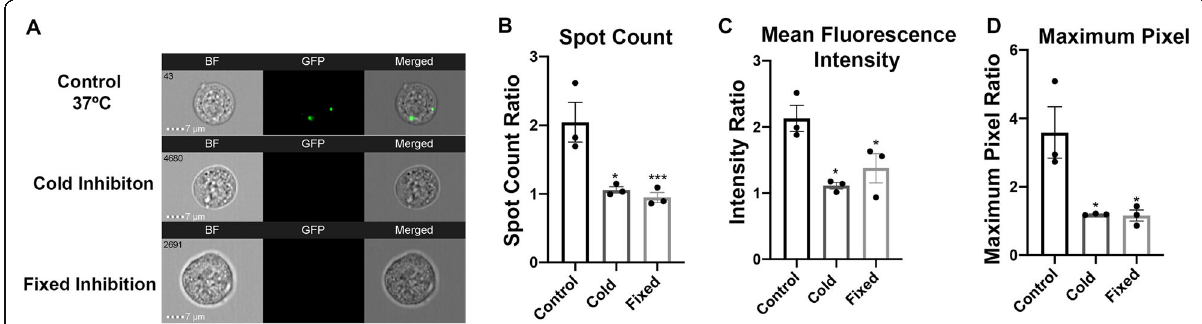
Fig. 2 EV internalization inhibition assays. HEK293T cells were co-cultured with HEK293T EVs under various conditions. Control (37 °C) refers to co- culture in physiological 37 °C environment. Cold refers to co-culture in a 4 °C environment. Fixed inhibition refers to an assay where recipient cells were PFA fixed prior to co-culture. a Representative IFC images of recipient cells. Column 1, BF, signifies bright field. Column 2, GFP, signifies green fluorescent protein (488 nm excitation laser), and Column 3 signifies a merge of BF and GFP. Control shows positive GFP representing EV internalization. b – d Quantification of inhibition assays compared to controls via spot count, mean fluorescence intensity, and maximum pixel. Bars represent mean ± SEM; N = 3; one-way ANOVA followed with Tukey ’ s post hoc test compared with control. * p < 0.05; *** p <